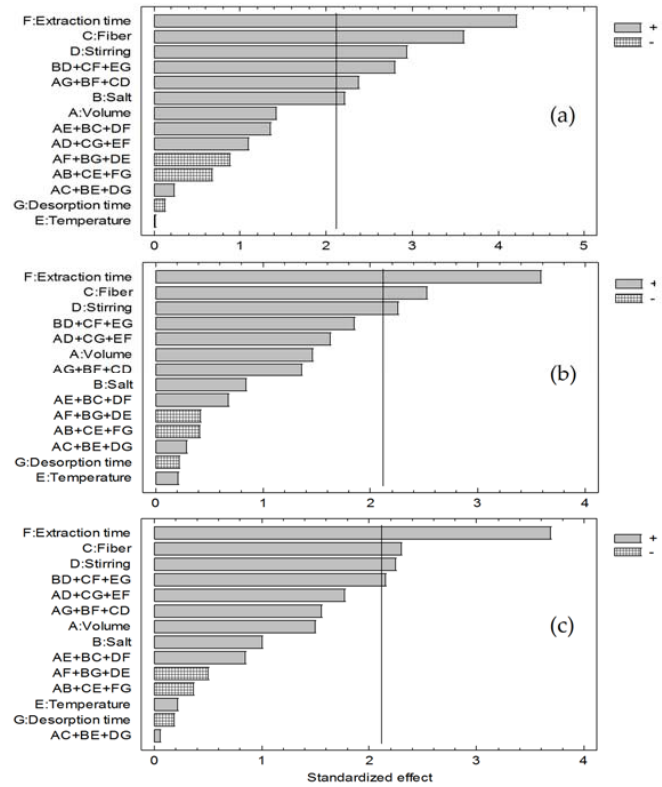
Figure 3. Pareto charts of the studied effects from the fractional factorial design 2 7–3 for ( a ) clofibric acid; ( b ) ketoprofen; and ( c ) naproxen.